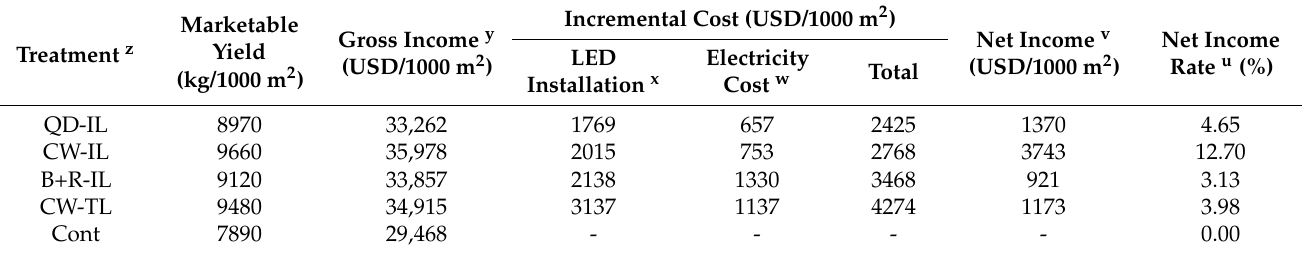
Table 5. Economic analysis of paprika fruits during the supplemental